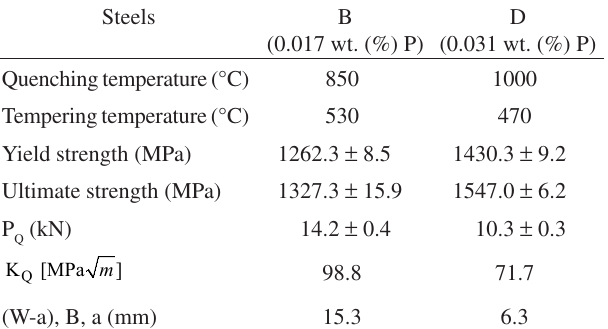
) and toughness (K ) for steels B and D. Q Q